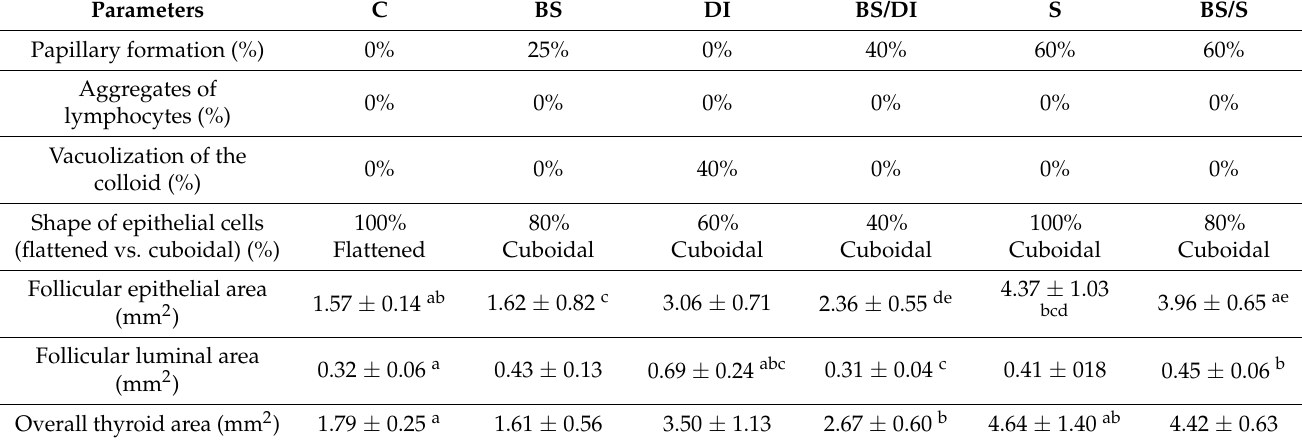
Table 3. Qualitative and quantitative parameters describing the changes observed during the histopathological examination of thyroid glands from the investigated rats (see Section 3.4.1 for an explanation of the groups’ acronyms).